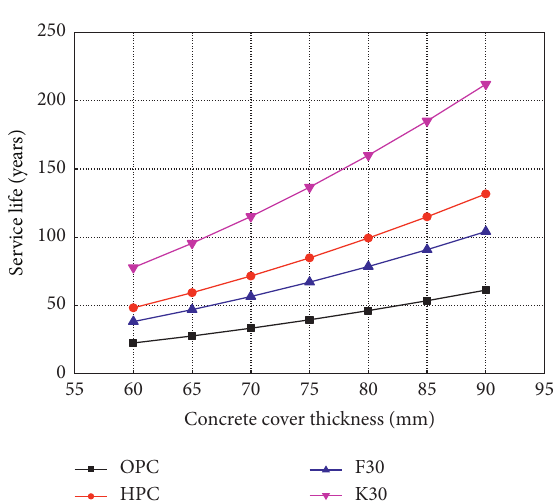
Table 4: Cost and CO 2 emission of raw materials of concrete production.